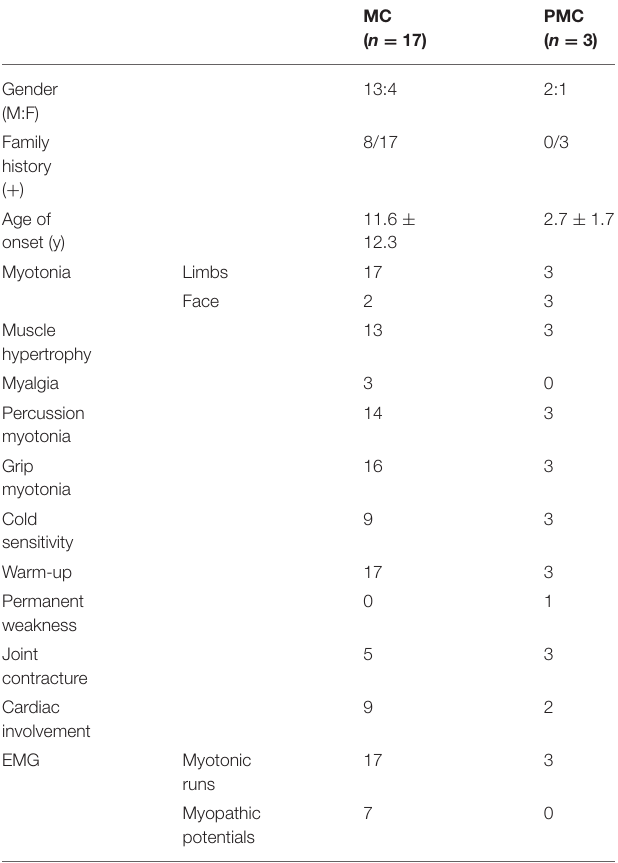
TABLE 3 | Comparison of clinical features between myotonia congenita and paramyotonia